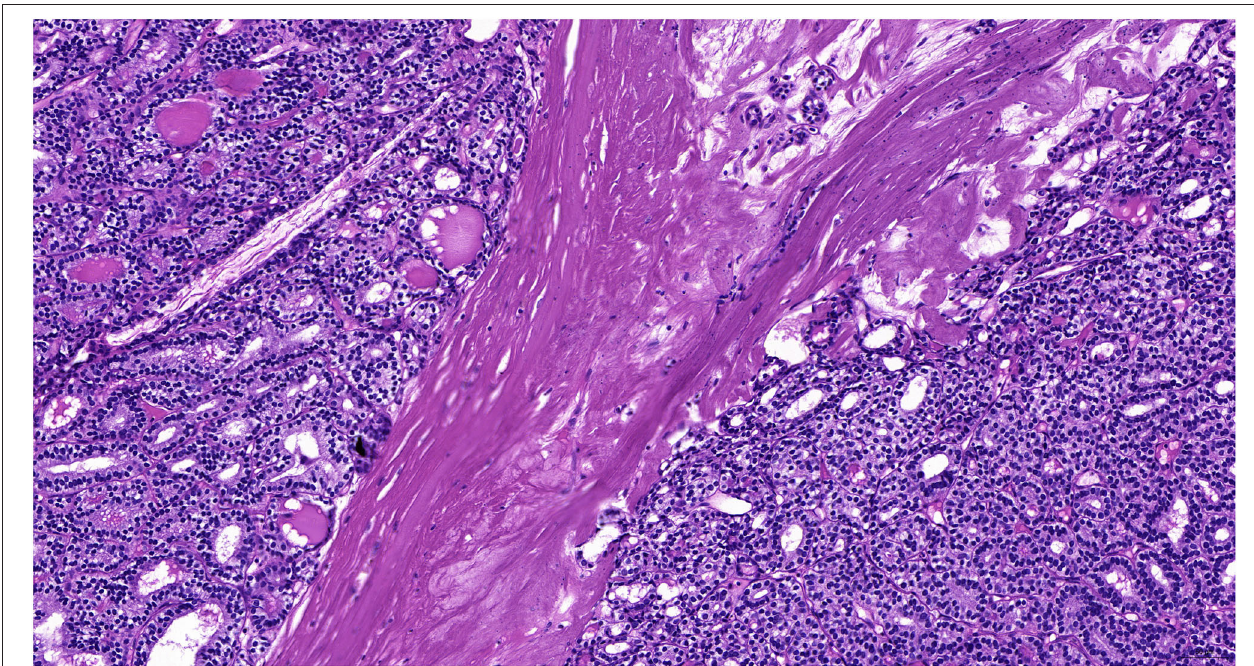
FIGURE 1 | The pathological results of follicular carcinoma arising in the struma ovarii in our case (H&E staining,